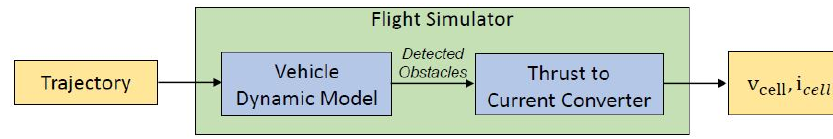
Figure 7. Flowchart of the EEPP algorithm.